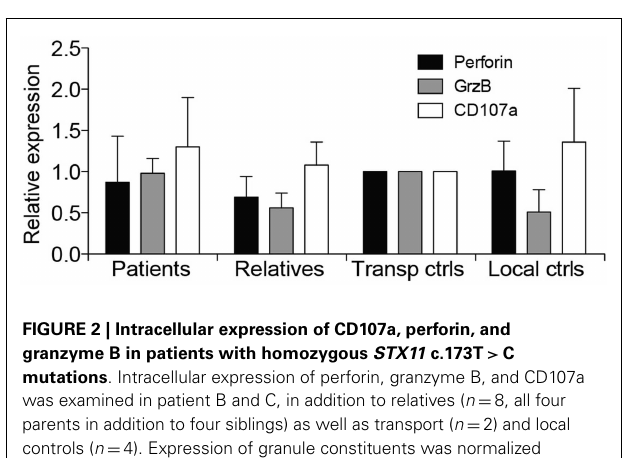
FIGURE 2 | Intracellular expression of CD107a, perforin, and granzyme B in patients with homozygous STX11 c.173T > C mutations . Intracellular expression of perforin, granzyme B, and CD107a was examined in patient B and C, in addition to relatives ( n = 8, all four parents in addition to four siblings) as well as transport ( n = 2) and local controls ( n = 4). Expression of granule constituents was normalized relative to that of the transport control. Bars indicate the mean value, Error bars indicate SD.